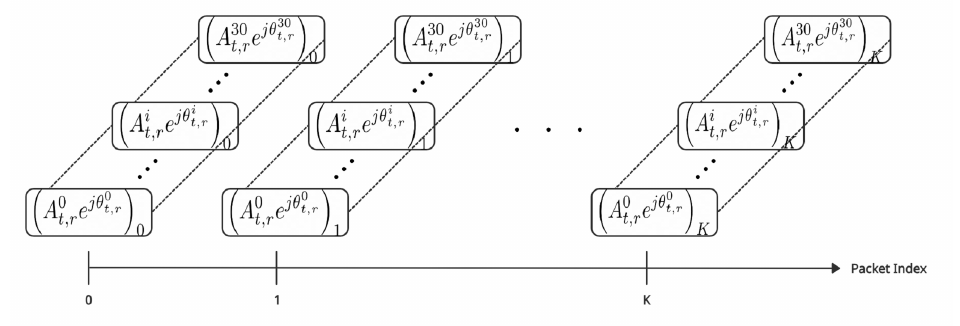
Figure 2. Technical diagram of received packets from a transmitter–receiver pair.